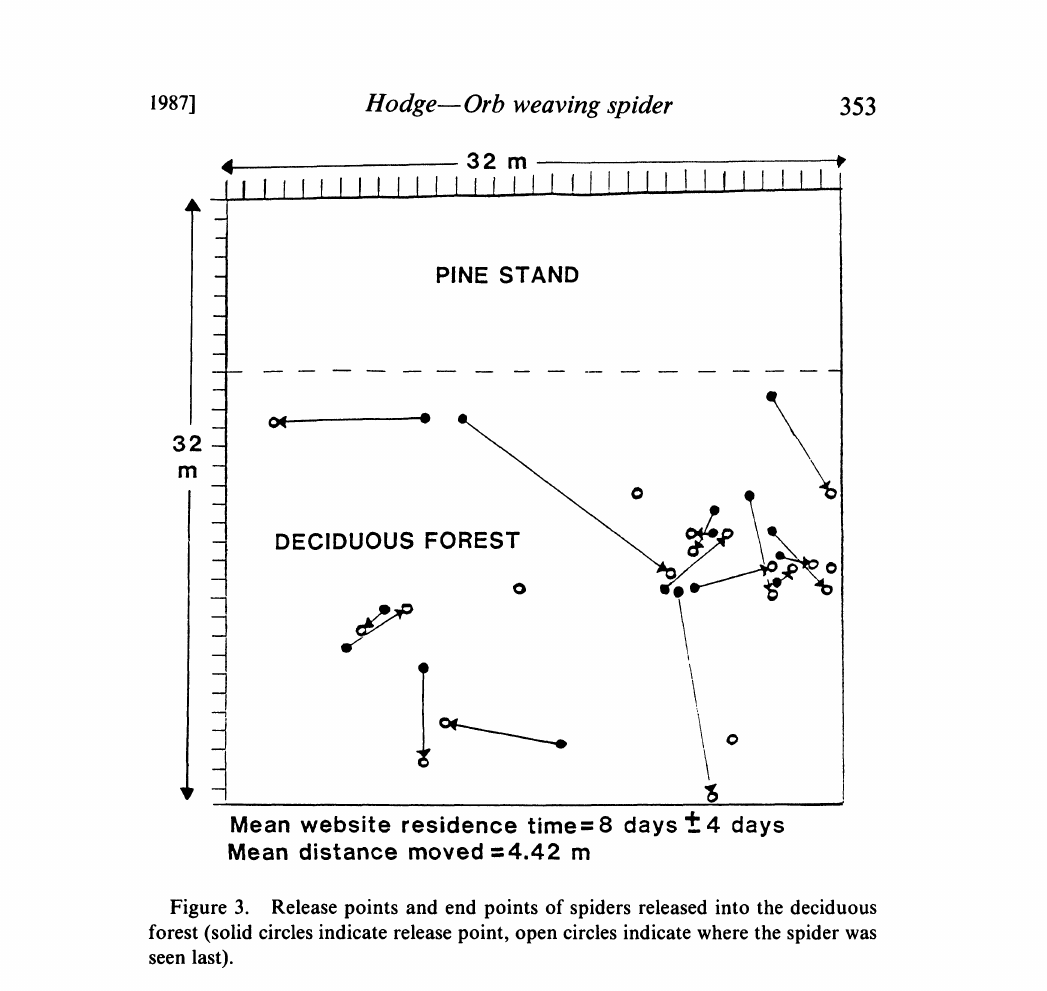
Figure 3. Release points and end points of spiders released into the deciduous forest (solid circles indicate release point, open circles indicate where the spider was seen